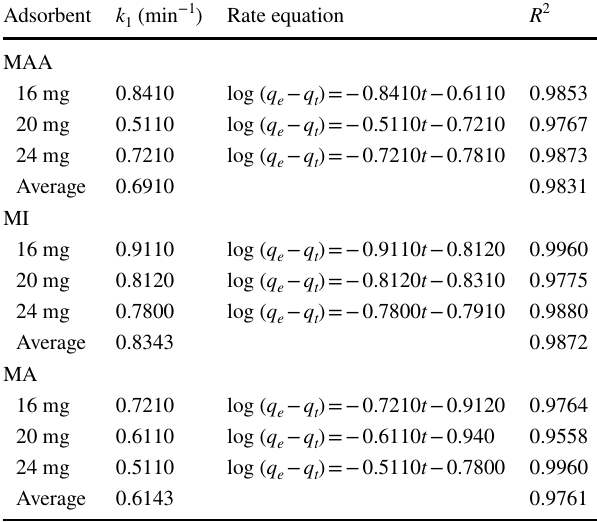
Table 2 Pseudo-first-order rate constants and the correlation coeffi- cients along with the rate